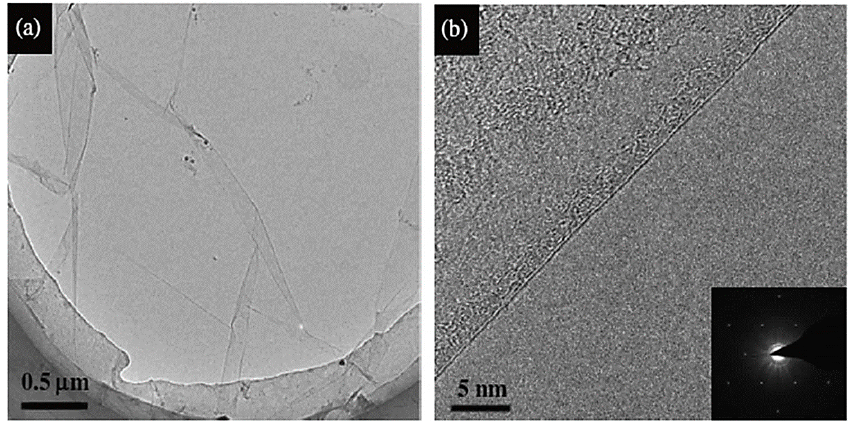
Figure 3. TEM micrographs of single layer Gp at ( a ) low and ( b ) high magnification. Reprinted with permission from [60]. Copyright RSC Publishers, 2017. permission from [60]. Copyright RSC Publishers, 2017.